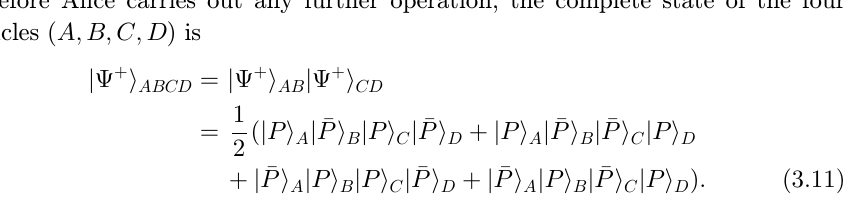
ðj P i C j (cid:1) P i D þ j (cid:1) P i C j P i D Þ to the packaged entangled 2 p